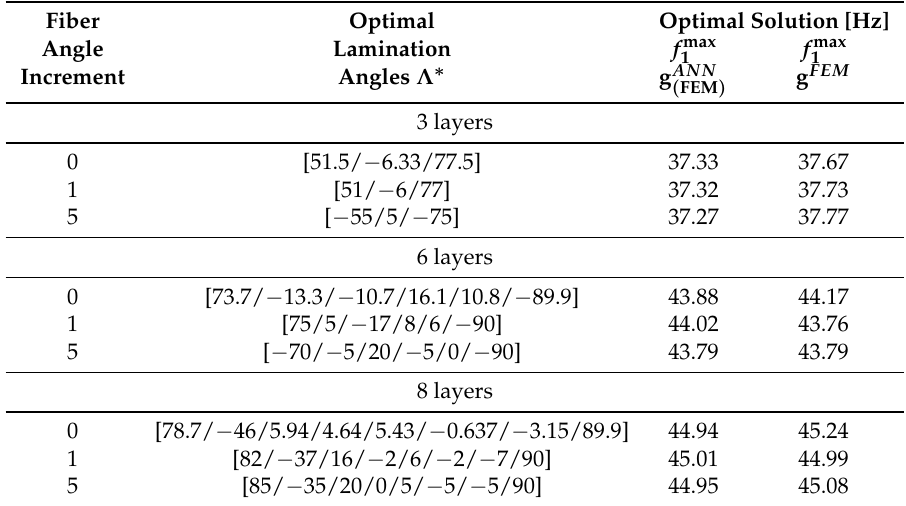
Table 7. Numerical results of f 1 optimization using MODEL1 with a different number of layers.